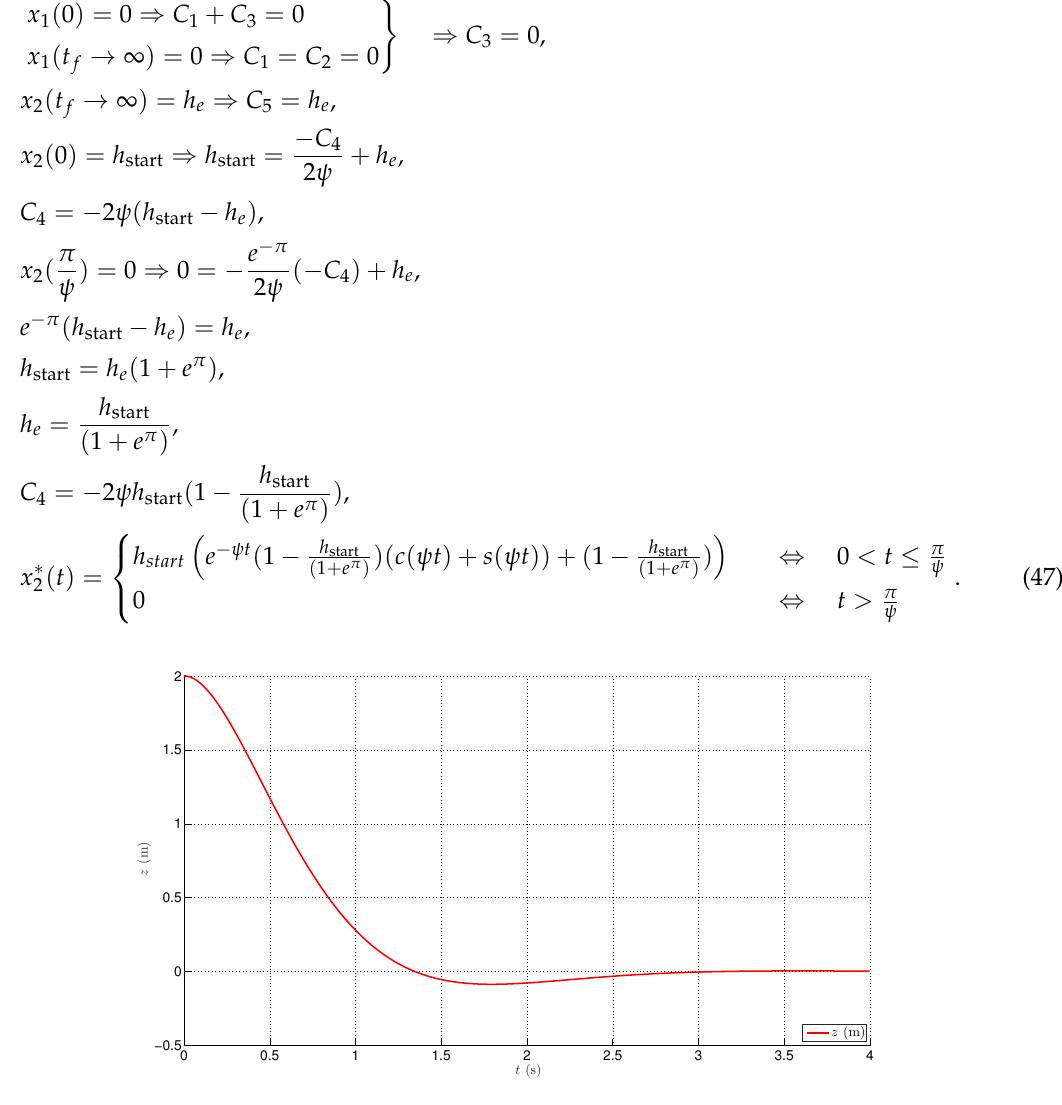
Figure 3. Minimum-energy trajectories—overshoot phenomenon.